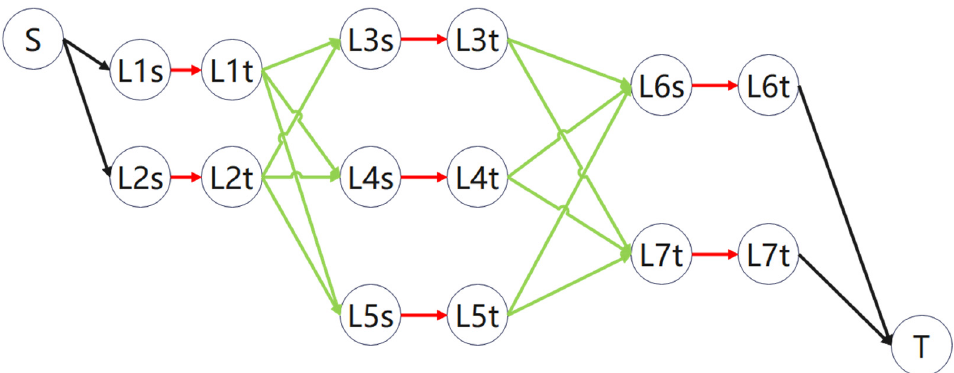
Figure 8. Global graph model (EGM), 3 steps, 7